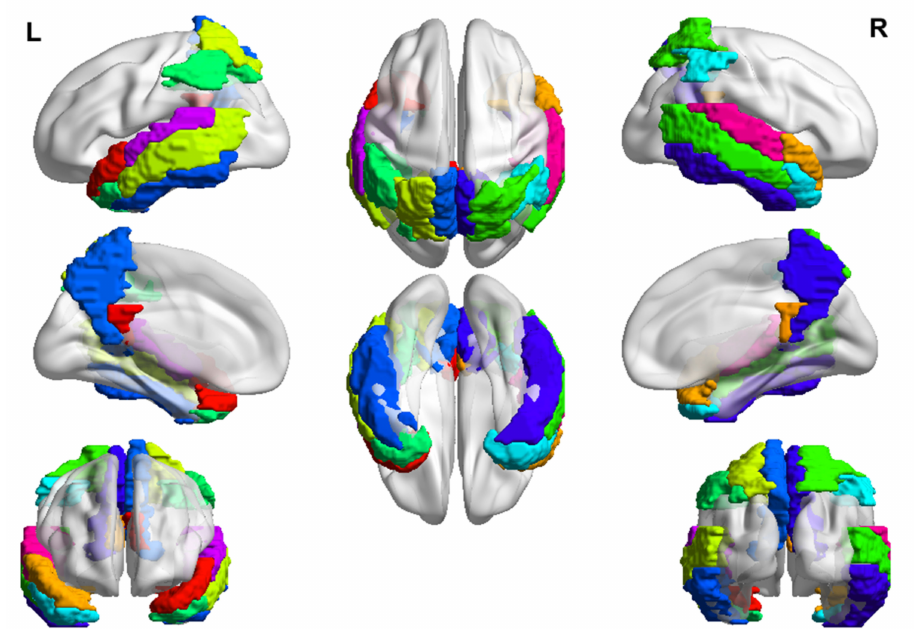
Figure 1. Brain regions that typically show hypometabolism from FDG-PET imaging. Images visualized with BrainNet Viewer [39]. In the top row, we see these areas on the left, top, and right of the outer surface of the brain. In the middle row, we see the left and right medial brain surfaces and the underside of the brain in the center. In the bottom row, we see the anterior and posterior views of the brain. Each color represents a distinct anatomical region of